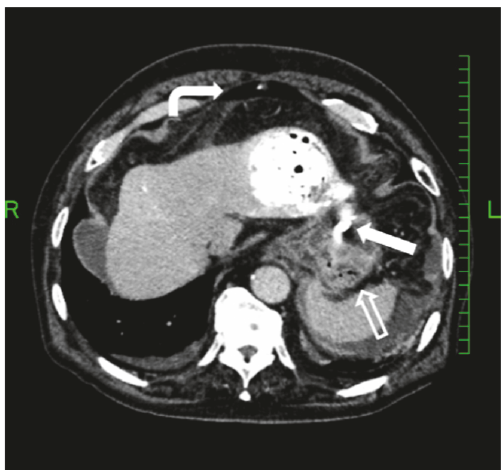
Figure 1: A contrast enhanced computed tomography scan of the abdomen showed iodized oil (arrow) and intraperitoneal free (curved arrow) air with a rupture of the HCC in segment II into the peritoneal cavity adjacent to the gastric wall (open arrow).